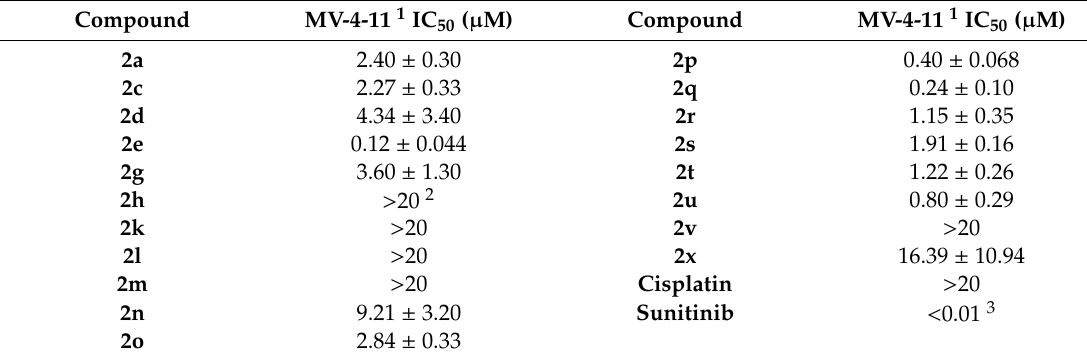
Table 2. In vitro antileukemia activity of benzofuro[3,2- c ]quinoline derivatives against the growth of the MV-4-11 cell line.